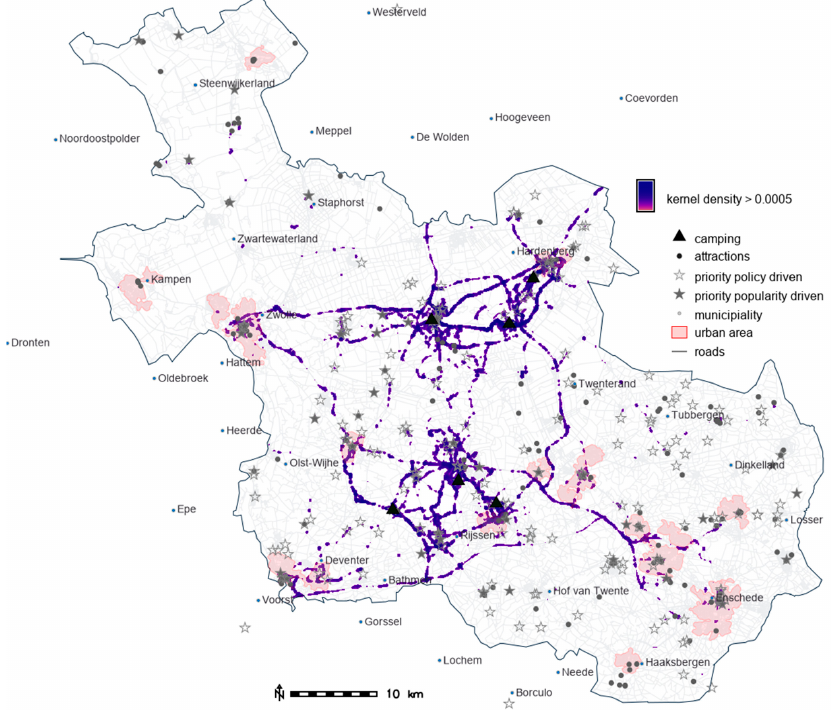
Figure 4. Most visited